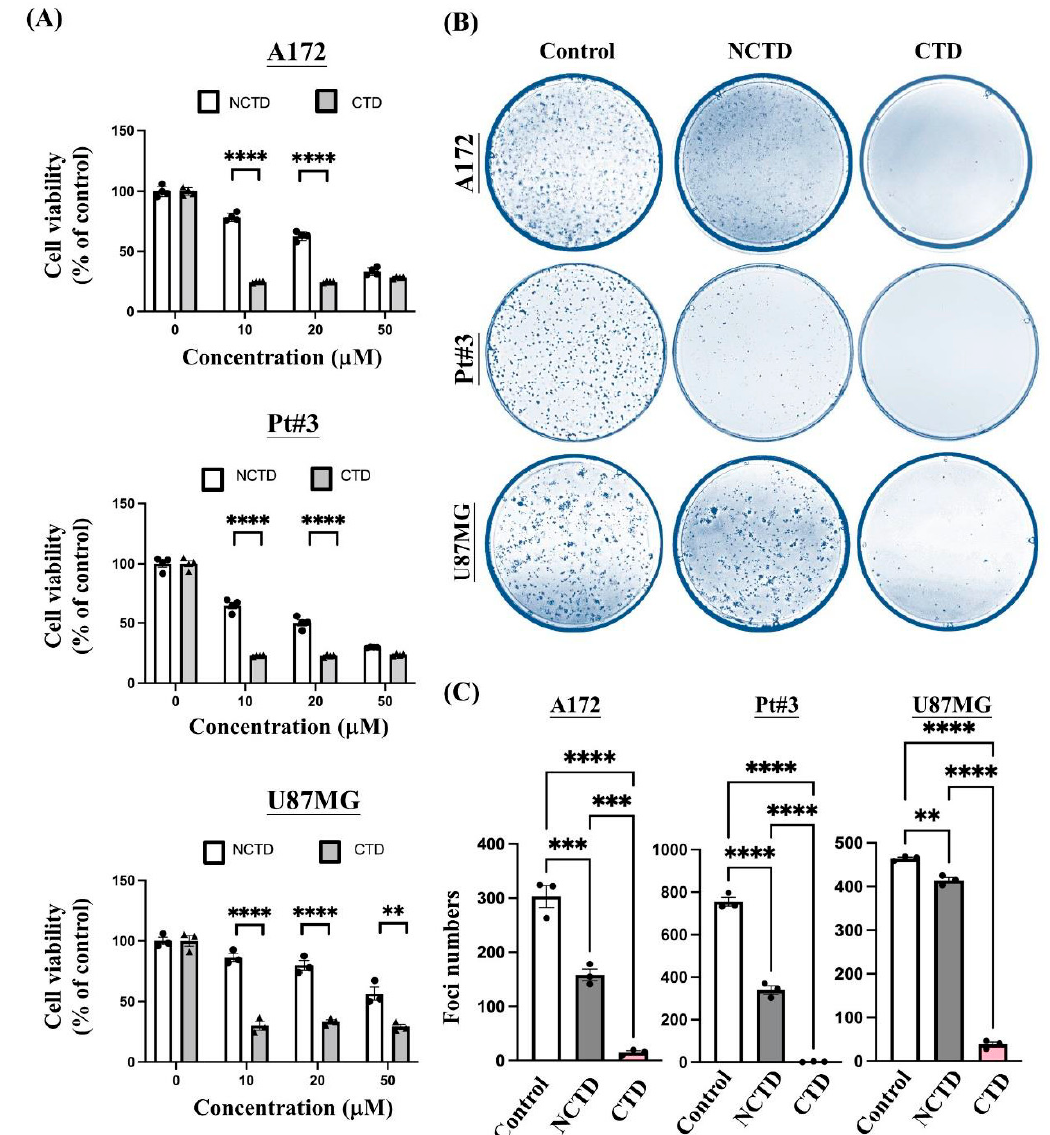
Figure 3. Cantharidin (CTD) had a greater inhibitory effect on glioma cell proliferation than norcantharidin (NCTD). ( A ) CTD exhibited a greater cytotoxic effect than NCTD in glioma cells (A172, PT#3, and U87MG). The cytotoxicity was evaluated using the CCK-8 assay. Data are collected from at least three independent experiments and presented as mean ± SEM; two-way ANOVA, ** p < 0.01 and **** p < 0.0001 (CTD vs. NCTD). The dose response analysis of CTD and NCTD in A172 and Pt#3 cells: 0 vs. 10, 0 vs. 20, and 0 vs. 50, p < 0.0001. The dose response analysis of CTD in U87MG cells: 0 vs. 10, 0 vs. 20, and 0 vs. 50, p < 0.0001; the effects of NCTD on U87MG cells: 0 vs. 20, p <